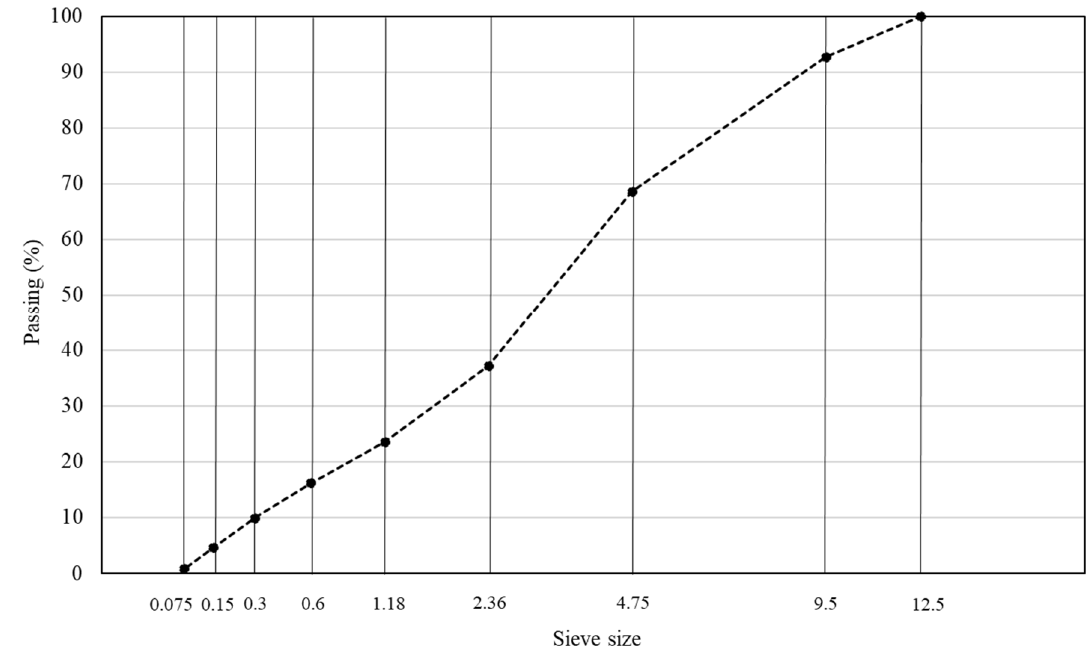
Figure 2. Aggregate gradation.